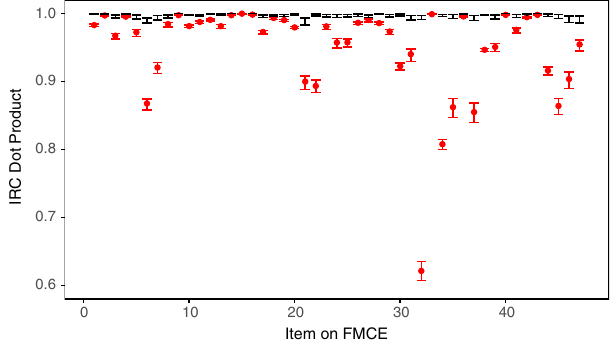
FIG. 7. The IRC dot product for each item on the FMCE is shown in red for our American dataset (RSW) and the IDW Japanese dataset (IDWJ). The red error bars around the data points represent the IRC dot product confidence intervals described in Sec. III C. The black error bars represent the randomized trial confidence intervals described in Sec. III B 3.